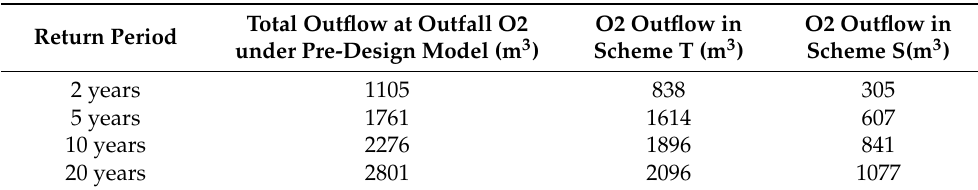
Table 4. Total outflow of outfall O2 (gradient = 20%) under the pre-design model, Scheme S, and Scheme T over different return periods.